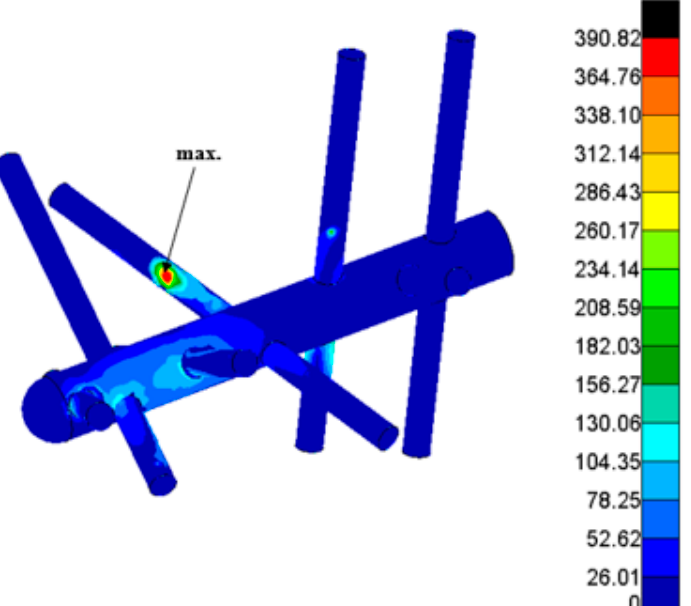
Figure 17. Distribution of the reduced stress on the calcaneal nail according to the HMH hypothesis/MPa/.